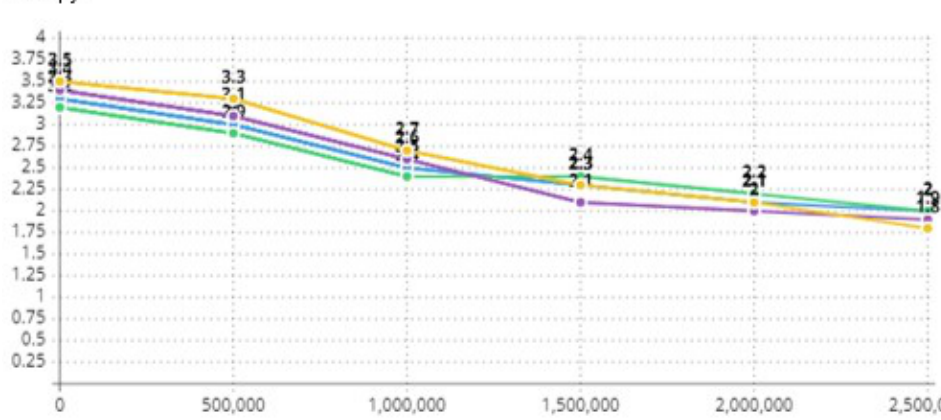
Figure 12. Entropy graph using the PPO algorithm.